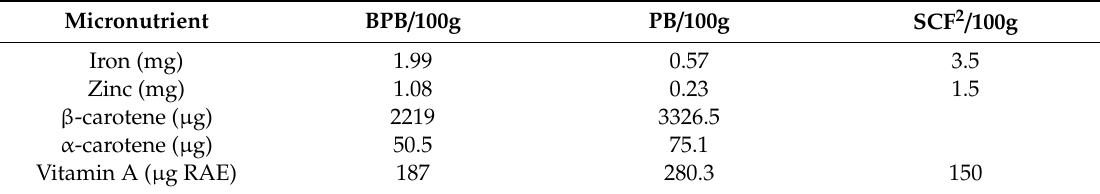
Table 2. Micronutrient composition of edible portion of BPB and pumpkin blend (PB). Micronutrient BPB /